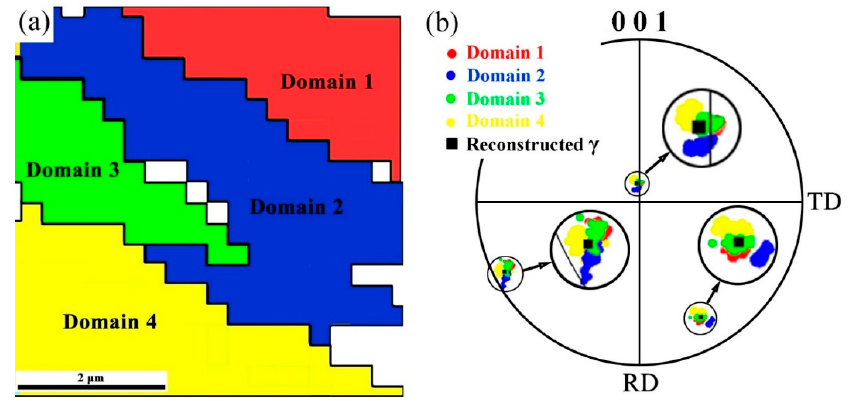
Figure 4. ( a ) Domains bearing the same variant of the OR in Figure 3a. ( b ) 001 pole figure of the potential γ orientations around the reconstructed γ orientation for Domains 1–4.